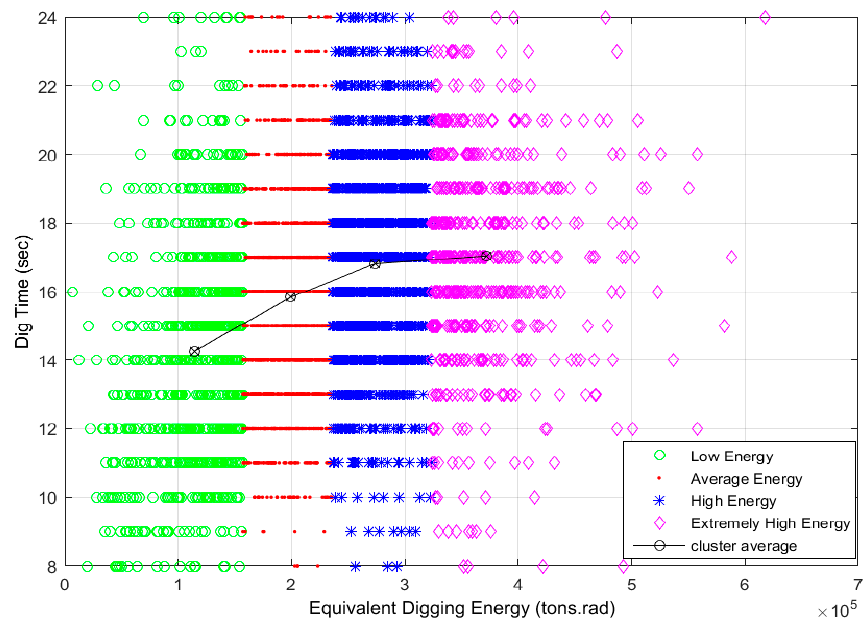
Figure 6. Result of clustering analysis for comparison of dig time and equivalent digging energy.